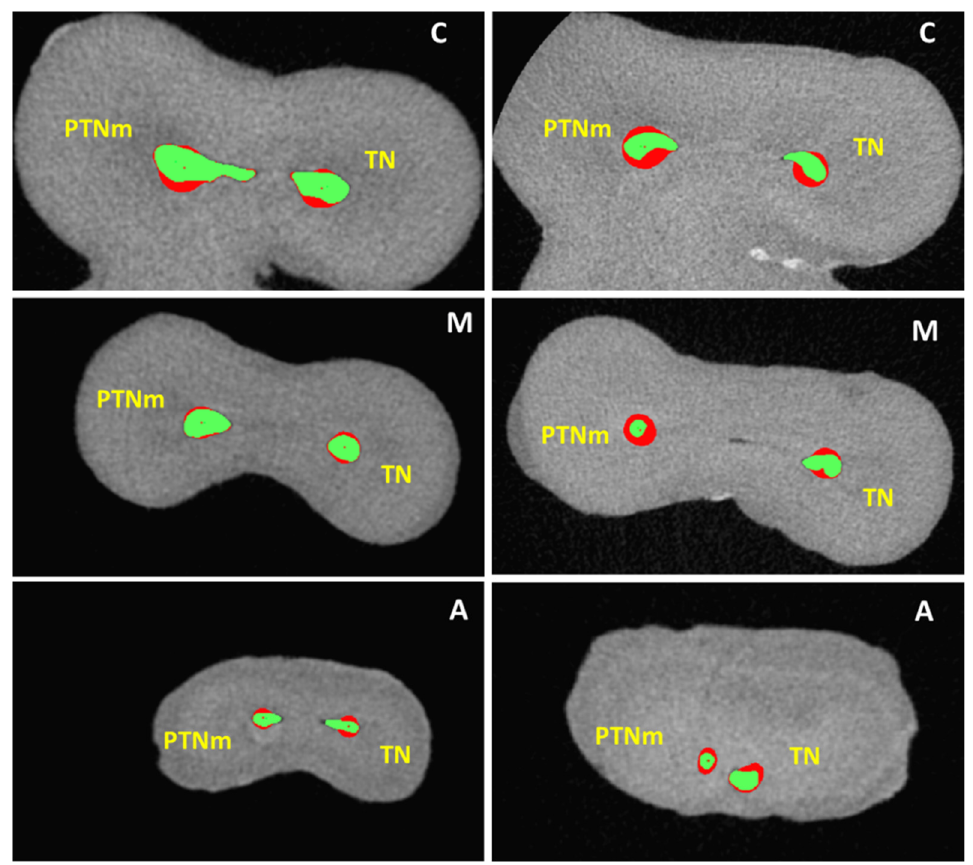
Figure 1. 2D matching of pre-operative (green) and post-shaping (red) canal sections at the apical ( A ), point of maximum curvature ( M ), and coronal ( C ) levels of analysis in both groups.